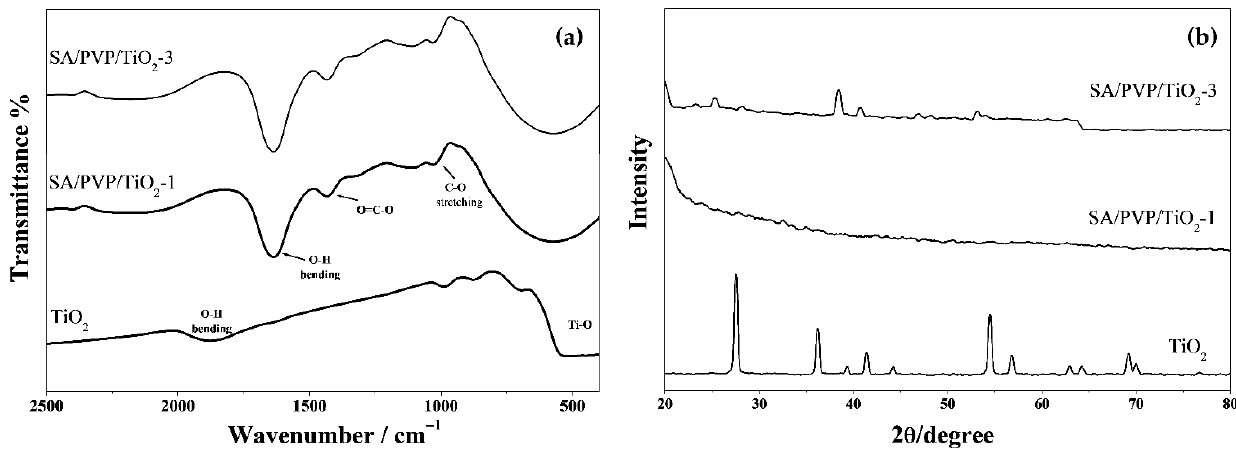
Figure 3. ( a ) FTIR spectra and ( b ) XRD spectra of the TiO 2 nanotubes and SA/PVP/TiO 2 nanocomposite beads.